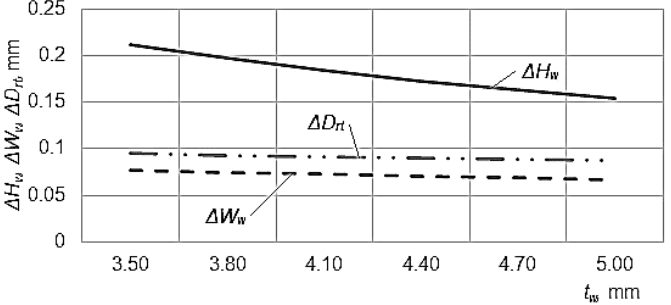
Figure 5. Influence exerted by the workpiece thickness t w on the deviations Δ H w , Δ W w , and Δ D rt ( l s = 6.5 mm, c s = 0.14 mm, c a = 0.54 mm).